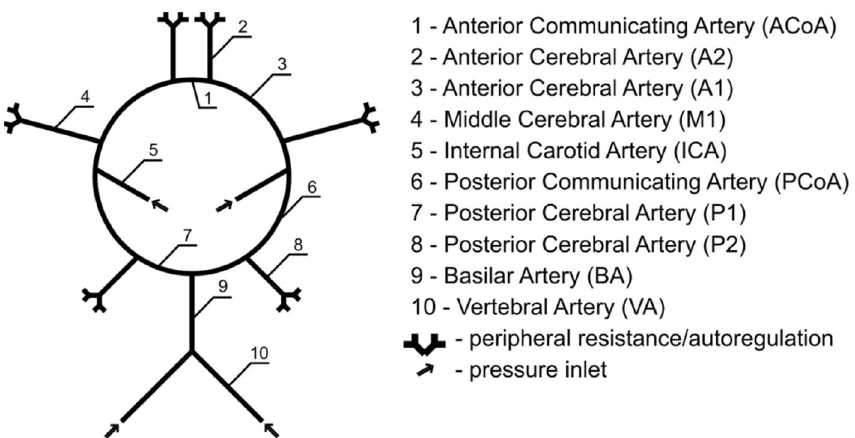
Figure 6. A nonlinear 0D 18-element model of the CoW.